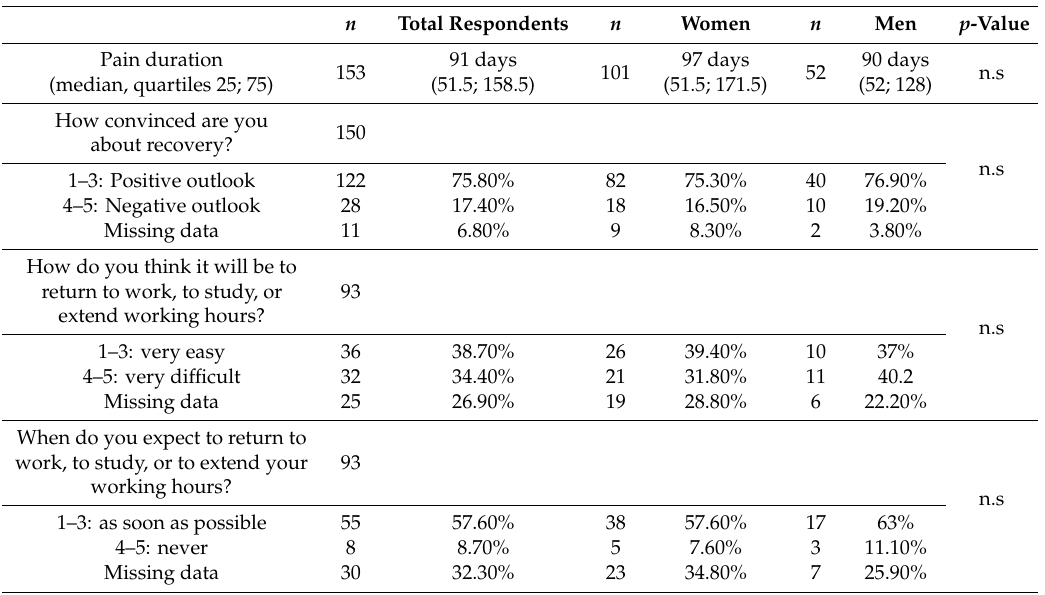
Table 2. Pain characteristics. Values for women and men are reported